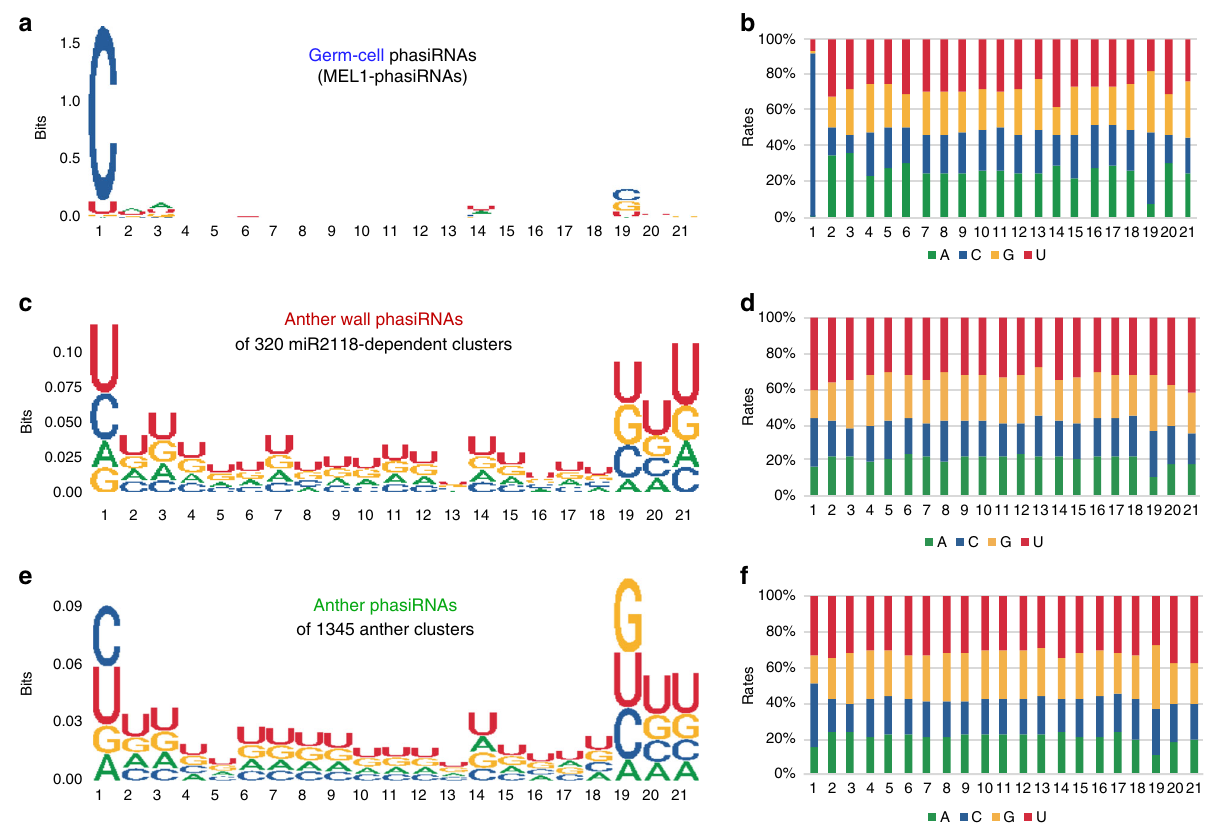
Fig. 5 U-rich phasiRNAs are enriched in the miR2118-dependent anther wall clusters. a , c , e Relative nucleotide bias at each position of the 21-nt phasiRNAs. b , d , f Relative frequency of each nucleotide in the 21-nt phasiRNAs. The 5 ′ terminals of phasiRNAs that interact with MEL1 are mainly “ C ” ( a , b ), while miR2118-dependent phasiRNAs from the 320 anther wall phasiRNA clusters are “ U ” rich, especially at the 5 ′ and 3 ′ ends ( c , d ). In the whole anther phasiRNAs, the 5 ′ -terminal sequence composition of “ C ” and “ U ” are comparable ( e , f